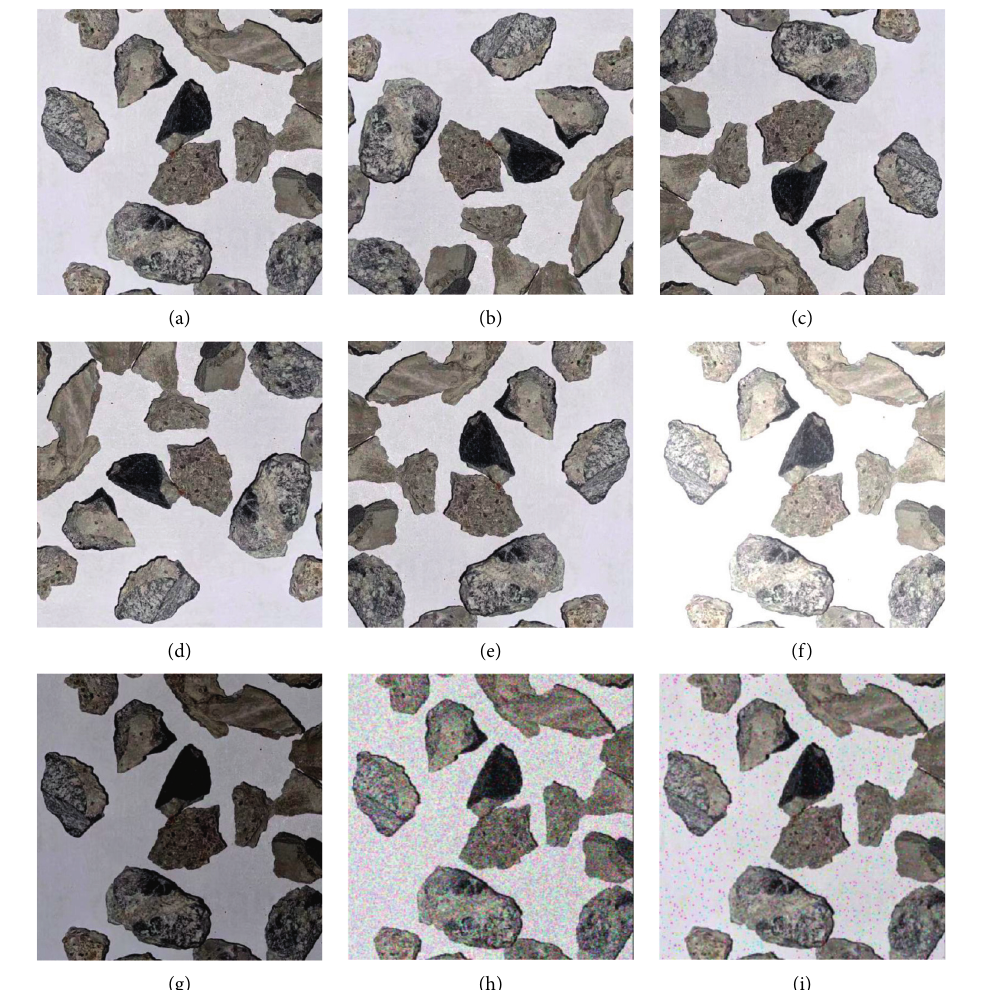
Figure 4: Data enhancement techniques: (a) initial image; (b–d) rotated image; (e) flipped image; (f-g) brightness transformed image; (h-i) image with salt and pepper noise.